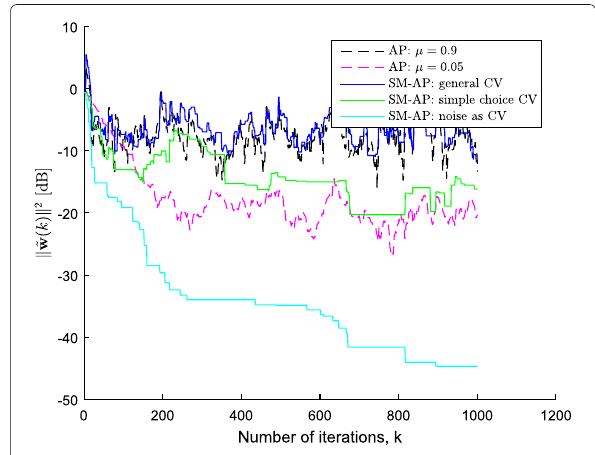
Fig. 5 Values of g 1 ( k ) and g 2 ( k ) over the iterations for the SM-AP algorithm with γ ( k ) = n ( k ) , where g 1 ( k ) and g 2 ( k ) are the numerator and denominator of (26) in Theorem 3, when an update occurs; otherwise, g 1 ( k ) = (cid:3) ˜ w ( k + 1 ) (cid:3) 2 and g 2 ( k ) = (cid:3) ˜ w ( k ) (cid:3) 2